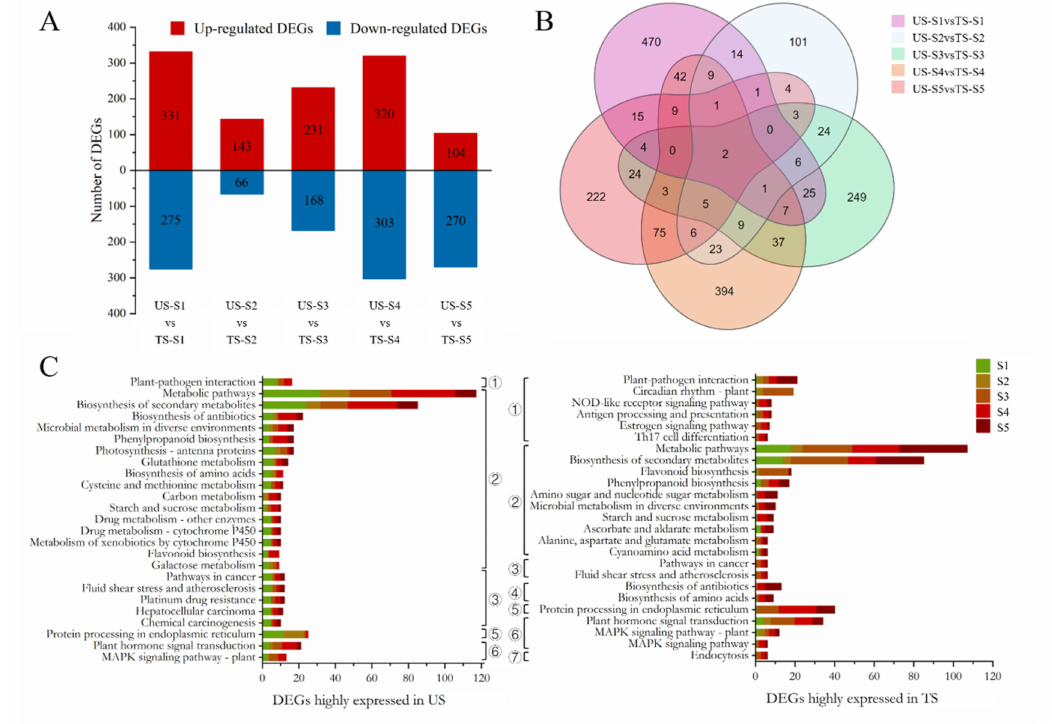
Figure 2. Transcriptomic profile of grape berries. ( A ): Comparison of the significantly up- and downregulated DEG numbers between TS and US at each stage (FC > 2, p < 0.01). ( B ): Venn diagrams of DEGs between TS and US at each stage. ( C ): KEGG classification of DEGs between TS and US at each stage. All the pathways were classified into seven categories, including (1): Organismal Systems; (2): Metabolism; (3): Human Diseases; (4): Global and Overview Maps; (5): Genetic Information Processing; (6): Environmental Information Processing; (7): Cellular Processes. TS: Turpan sample; US: Urumqi